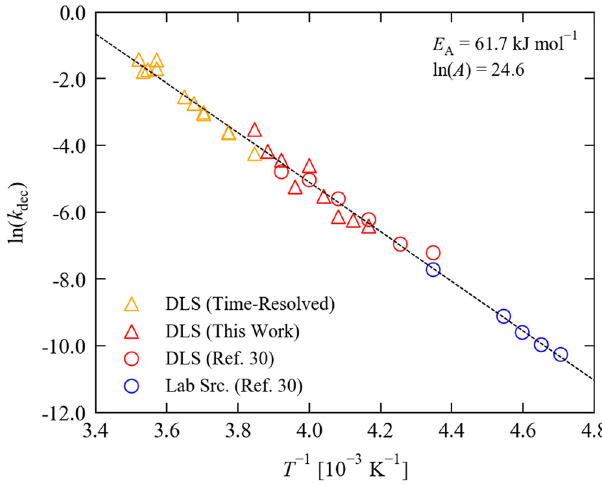
Fig. 3 Temperature dependence of the decay rate of the metastable isomer of 1. The plot shows an Arrhenius analysis of decay rate constants k obtained from three sets of measurements, viz . low- and mid-temperature photocrystallographic decay measurements, performed using a lab source (blue) and at the Diamond Light Source synchrotron facility (DLS - red), and high-temperature time-resolved measurements performed with our pump-multiprobe strategy (yellow). The black line is a fi t to the Arrhenius law with the fi tting parameters as shown. The low-temperature and some of the mid-temperature data are taken from our previous work 30